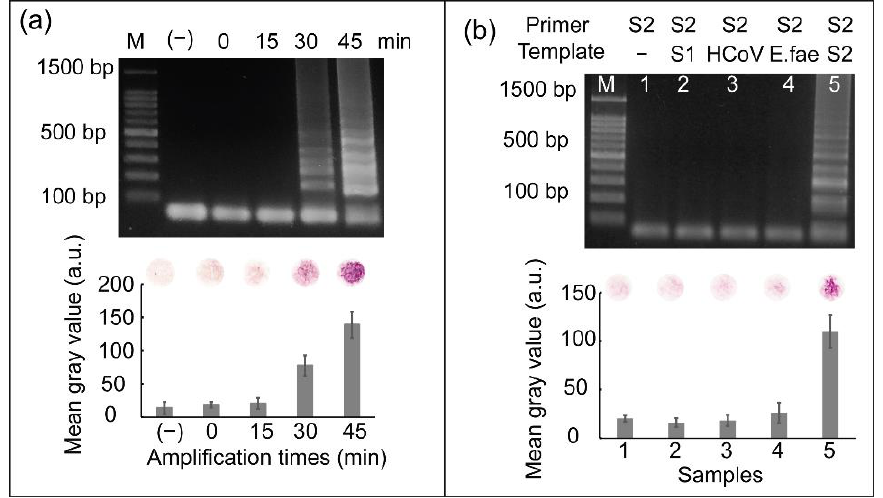
Figure 5. ( a ) Results showing the effect of amplification time on screening SARS-CoV-2 and ( b ) results of the specificity test of RT-LAMP coupled with colorimetric detection for screening SARS-CoV-2. Here, M represents 100 bp ladder, lane 1: RT-LAMP reaction not containing RNA template and lanes 2 – 5: RT-LAMP reaction containing RNA from SARS-CoV, HCoV-OC43, E. faecium , and SARS-CoV-2, respectively. All the experiments were repeated three times.